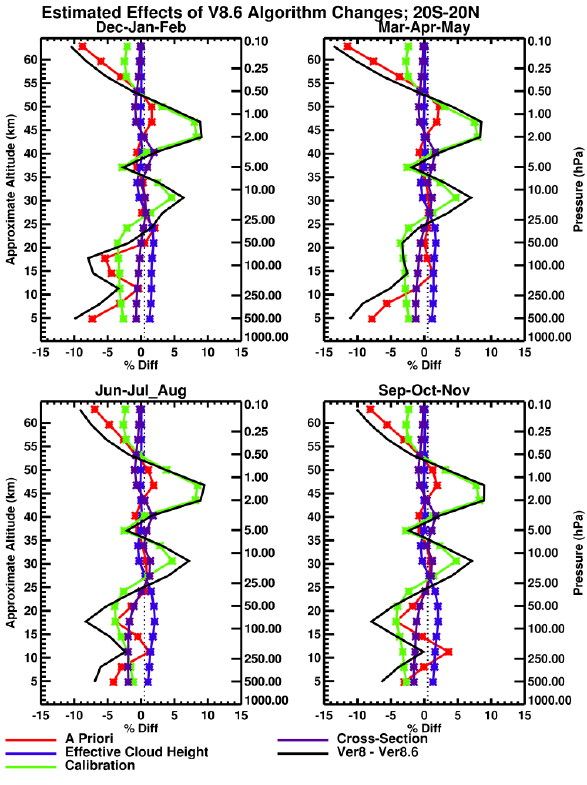
Fig. 2. Estimated effects of individual algorithm parameter changes from V8 to V8.6 of the SBUV algorithm in the tropics. The effects are estimated from a series of test retrievals replacing V8.6 parameters with those used in V8, one parameter at a time. Tests shown are for the change in a priori, cloud height, calibration and cross-section. The retrieval tests were run using N17 SBUV data in 2007. Daily zonal mean differences are shown for 3-month periods to highlight seasonal differences, which are minimal in the tropics. Final V8-V8.6 ozone profiles are shown in black. Differences in V8.6 are dominated by calibration changes in the middle stratosphere, and by a priori changes at the top and bottom of the profile. The cross-section and mean cloud height changes are smaller and tend to cancel each other below 25 hPa.